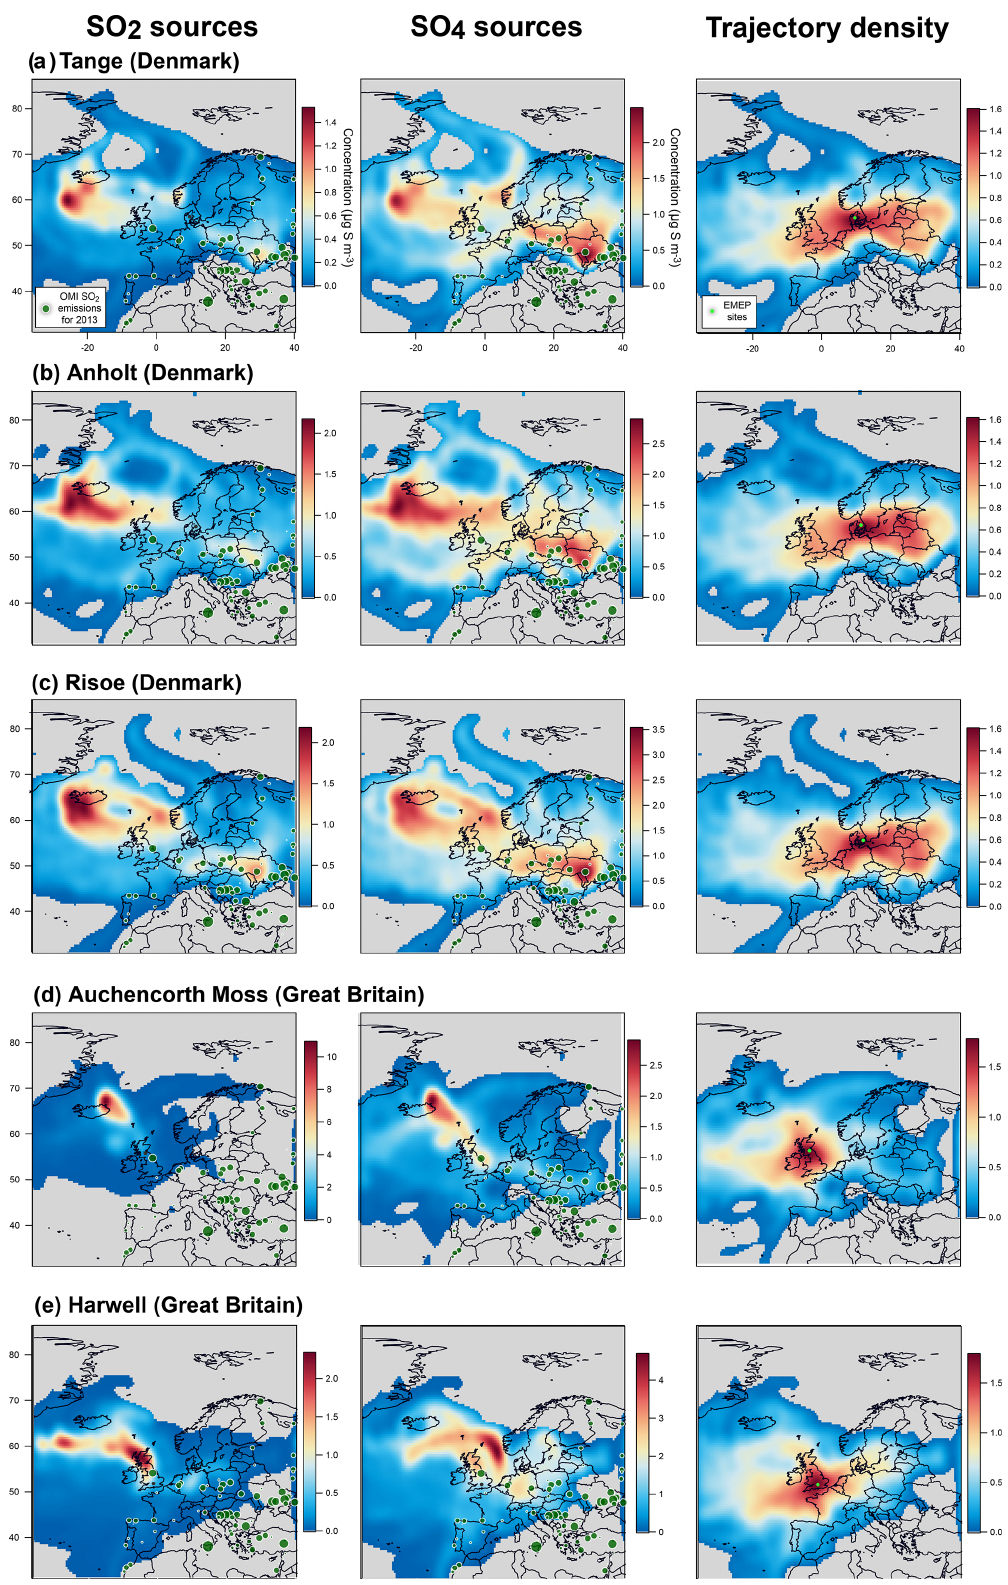
Figure A5. Same as Fig. A4 for EMEP stations in Denmark (Tange – a , Anholt – b , Risoe – c ) and Great Britain (Auchencorth Moss – d and Harwell – e